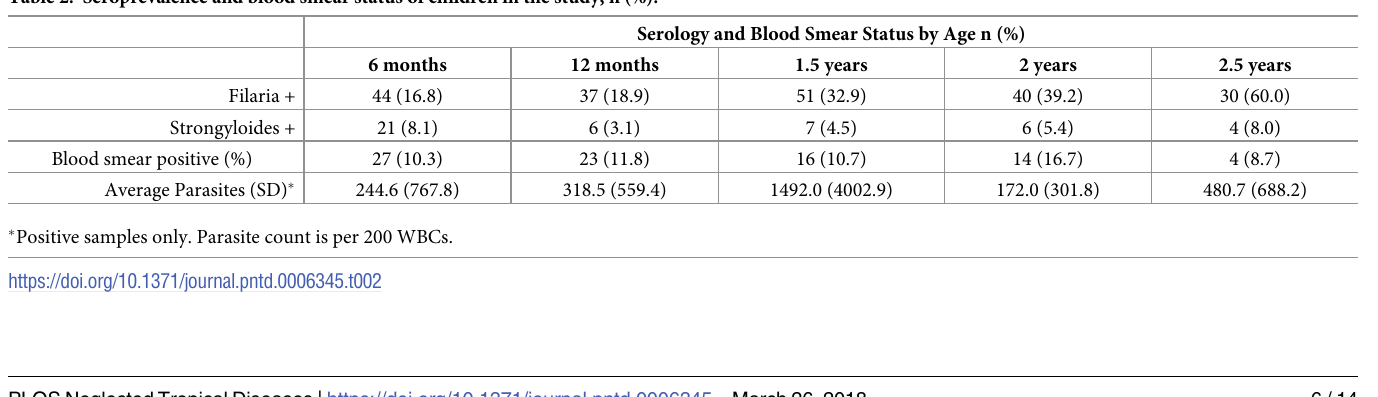
Table 2. Seroprevalence and blood smear status of children in the study, n (%).